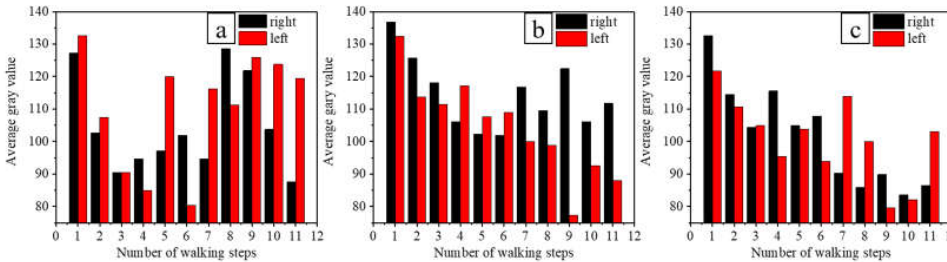
Figure 5. Difference in walking between the left and right feet, wherein the average gray value of the fluorescent solution was determined for each step number. ( a – c ) Volunteers No. 1–3, respectively. Table 2. Paired sample t -test for walking differences between the left and right feet. Group t Degrees of Freedom Significance (Two-Tailed) Volunteer No. 1 0.668 10 0.519 Volunteer No. 2 −1.234 10 0.246 Volunteer No. 3 1.074 0.308